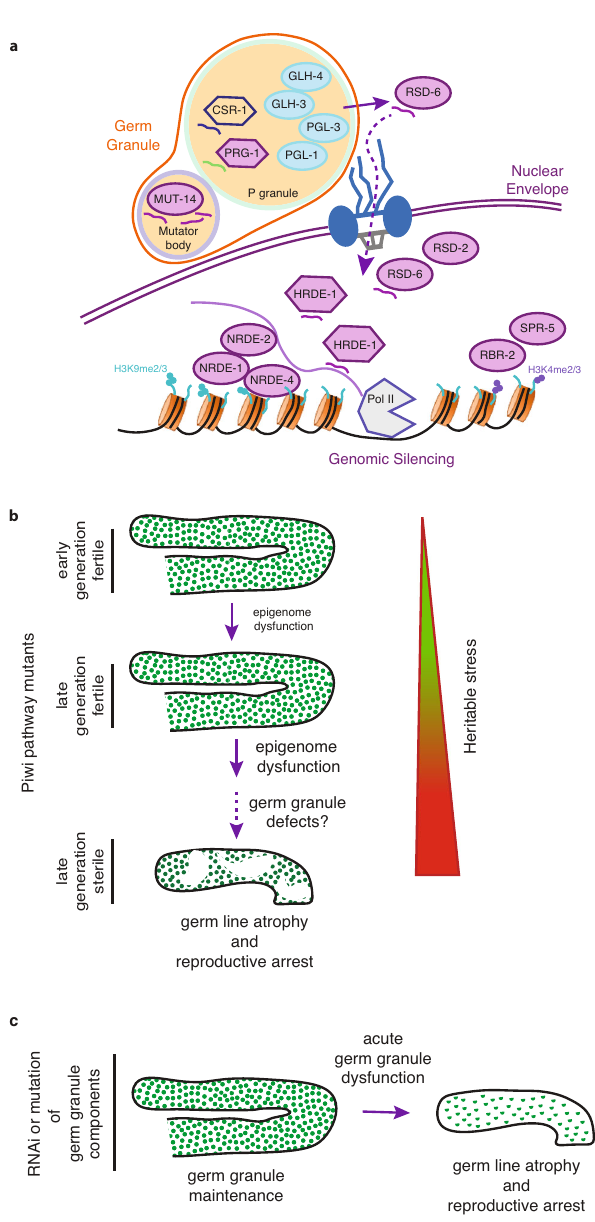
Fig. 7 Model for P granule dysfunction in Piwi pathway genome silencing mutants. a Model of P granules and associated small RNA-mediated genome silencing proteins. Blue circles contain P granule components analyzed in this paper. Mutants used in this paper are in lavender. Argonaute proteins are hexagons. Simpli fi ed representation of the